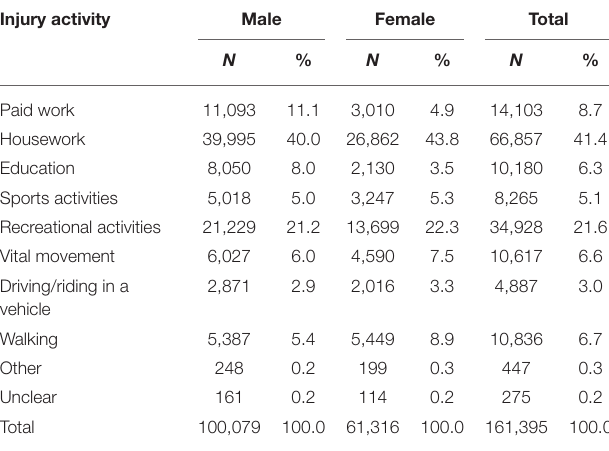
TABLE 3 | The proportion of injuries sustained during different activities by